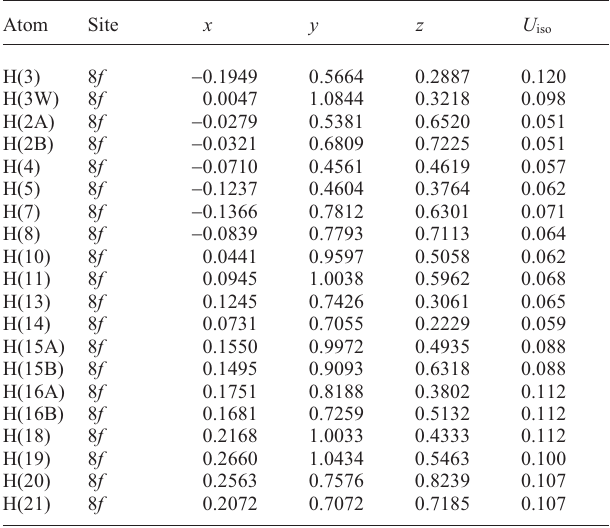
Table 2. Atomic coordinates and displacement parameters (in Å 2 )